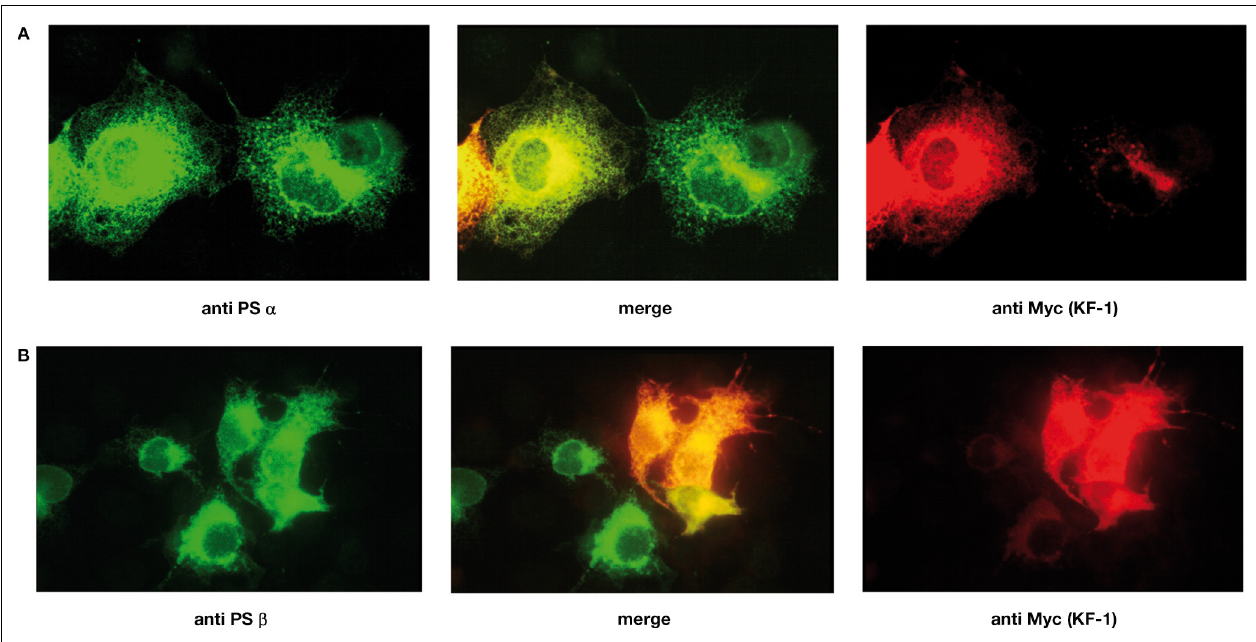
isothiocyanate (FITC) conjugated to anti-rabbit IgG for PS α (green). Images of ‘anti Myc (KF-1)’ and ‘anti PS α ’ are merged (‘merge’). (B) The same as